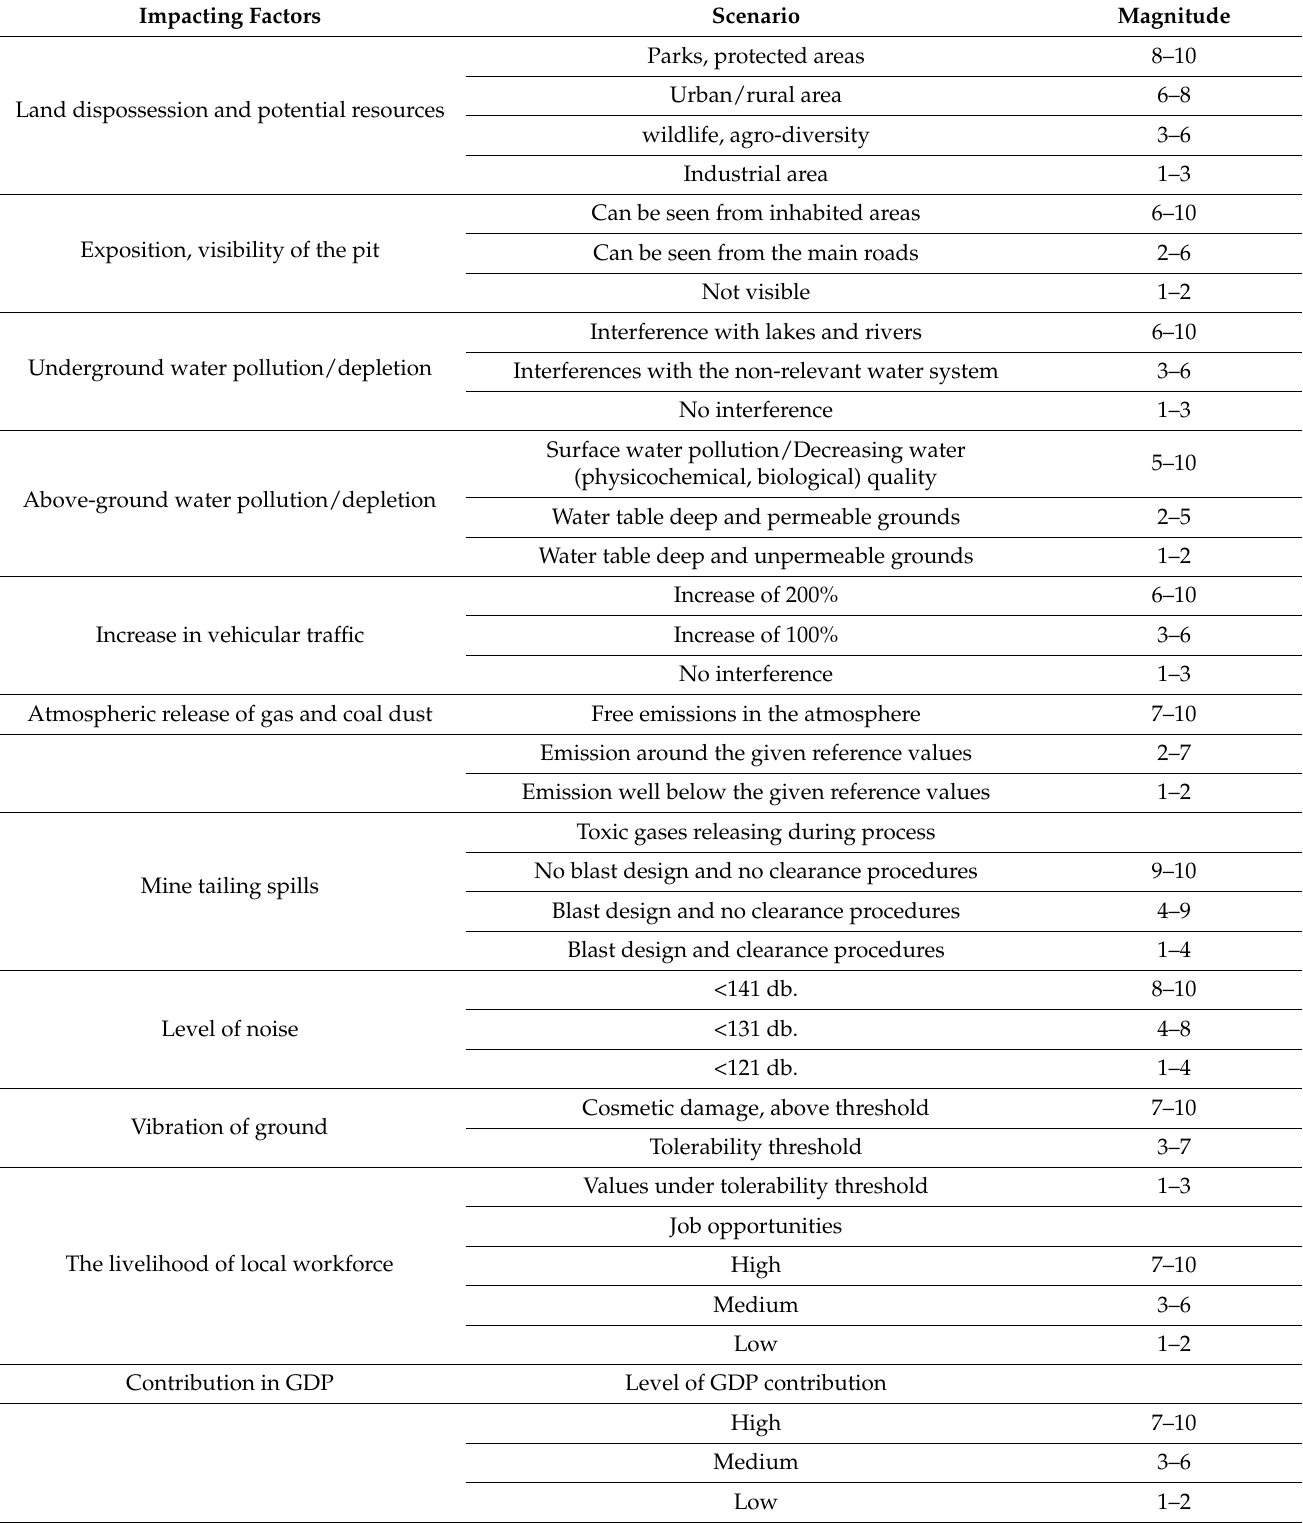
Table 2. The magnitude of impacting